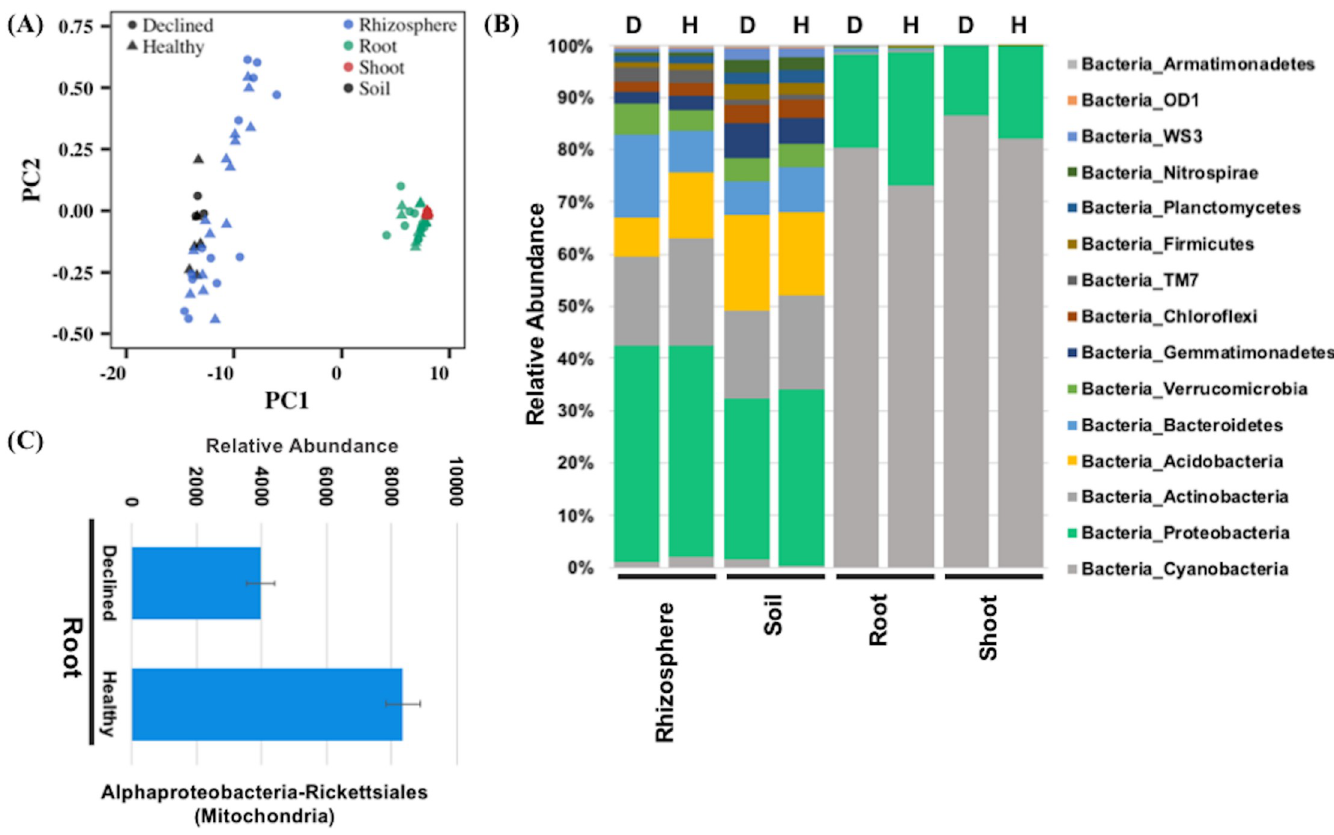
Fig 6. Analysis of bacterial communities in root, shoot, soil, and rhizosphere samples from asymptomatic and symptomatic ‘HoneyCrisp’ apple trees as identified by sequencing 16S regions. (A) Biplot from principal component analysis of the diversity indices obtained from 16S analysis of different samples, (B) Abundance of different bacterial classes in the rhizosphere, soil, root, and shoot samples, (C) Bacterial classes that show a significantly differential abundance between healthy and declined apple trees.